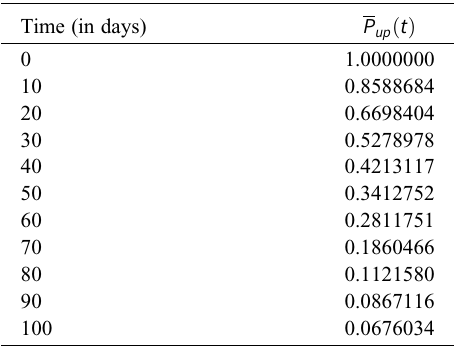
Availability variation in relation to